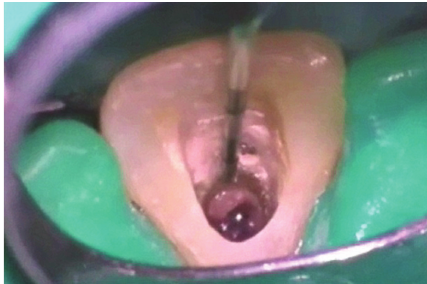
Figure 3: The massive root defect was located 15 mm below the incisal edge.